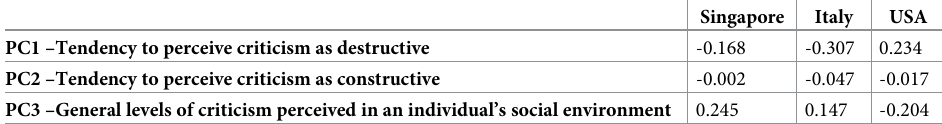
Table 6. Table of means for principal components by country.